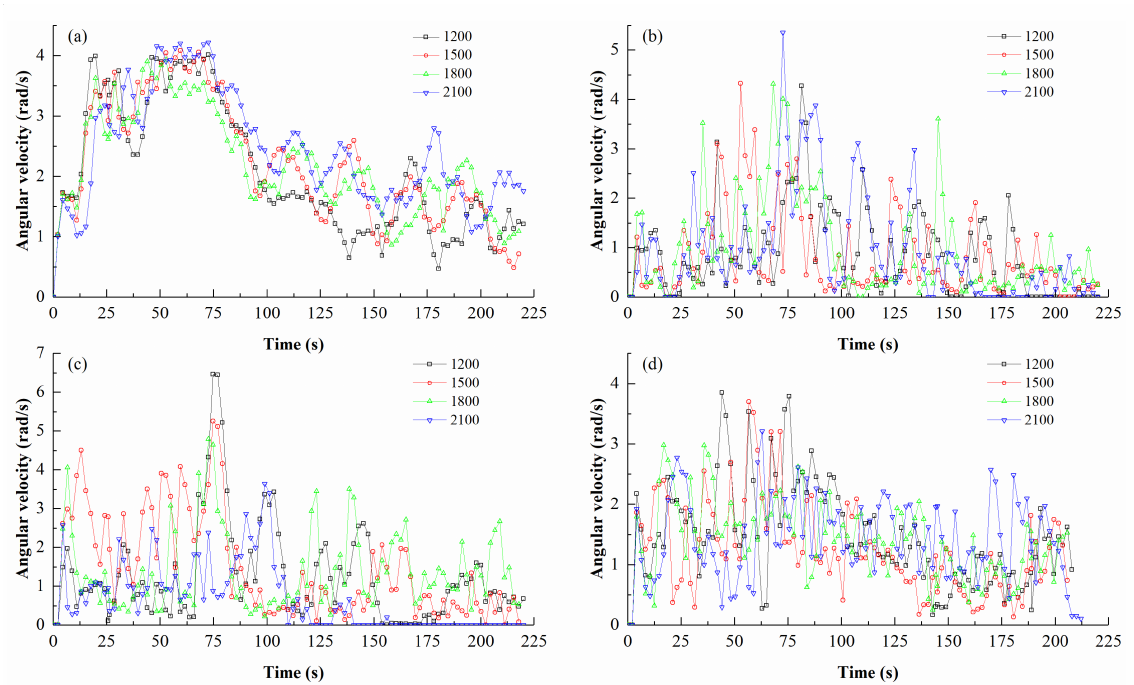
Figure 9. Influence of debris flow density on angular velocity of boulders with different shapes: ( a ) spherical, ( b ) cuboid, ( c ) rhombohedron, and ( d )